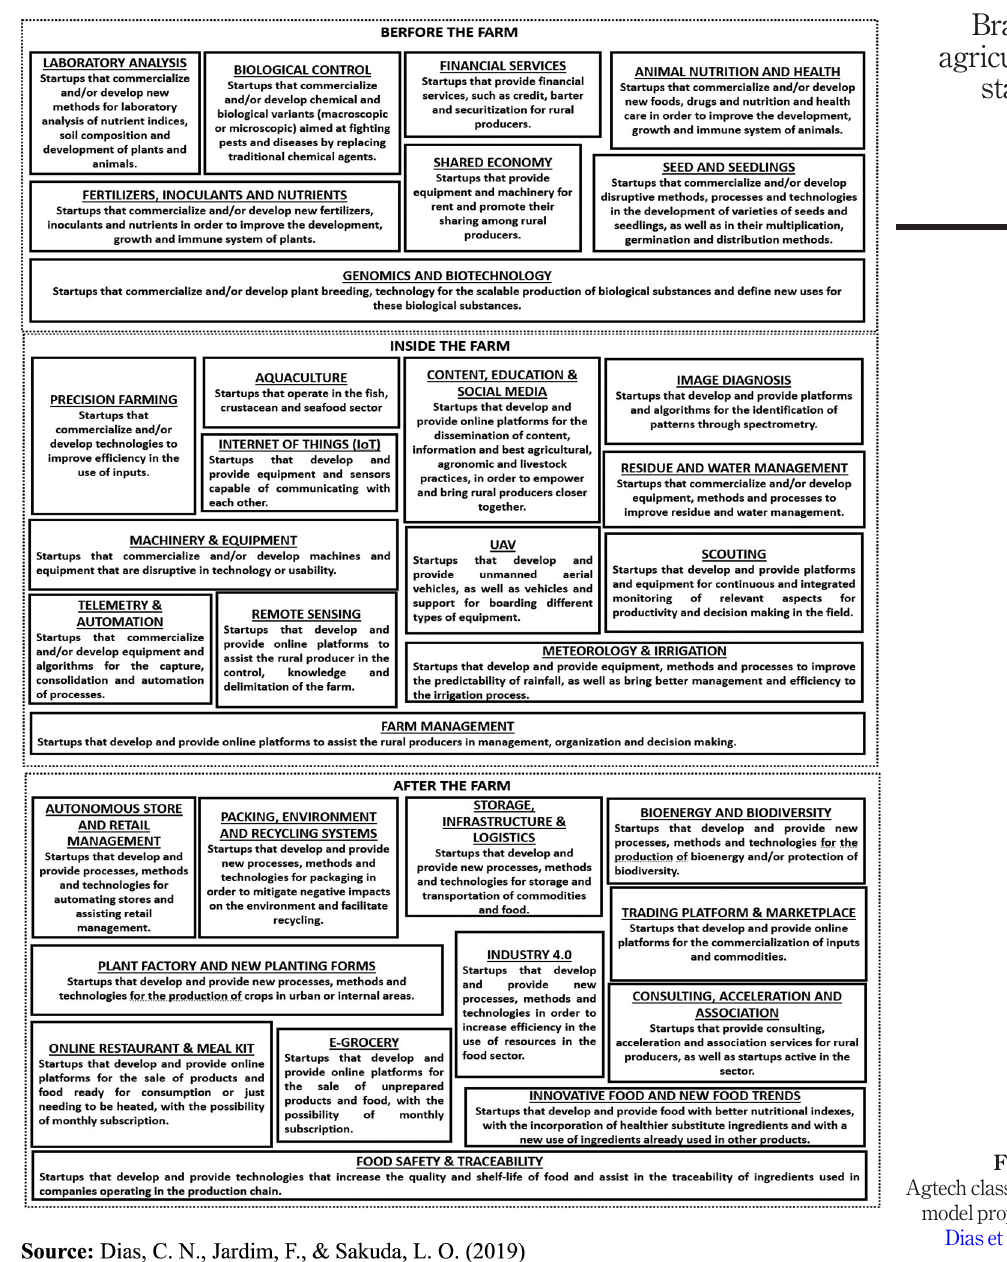
Figure 3. Agtech classi fi cation model proposed by Dias et al.